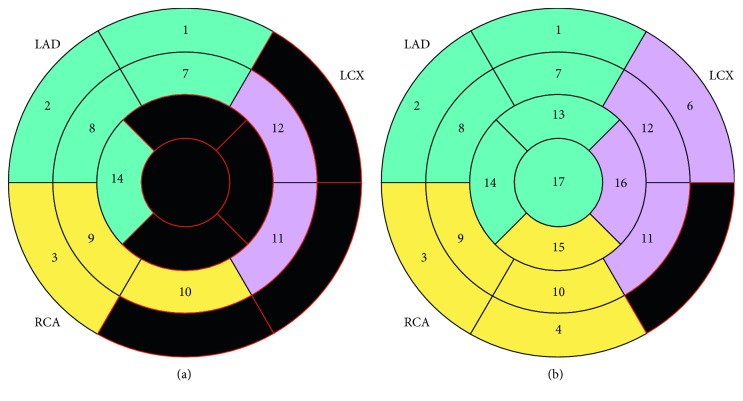
Results of the (a) LGE and (b) edema distribution in a 17-segment heart model. LAD: left anterior descending; RCA: right coronary artery; LCX: left circumflex. Modified from http://www.pmod.com/files/download/v34/doc/pcardp/3615.htm.